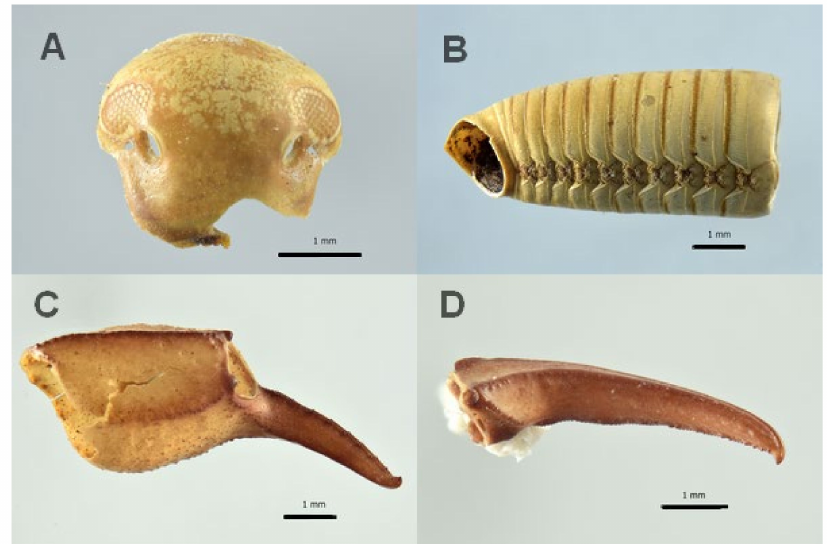
Figure 6. Julida and Scorpiones arthropod remains associated to the burial site of Saint Davino Armeno: ( A ) Julida head frontal view; ( B ) distal metamera; ( C , D ) Scorpiones, chela